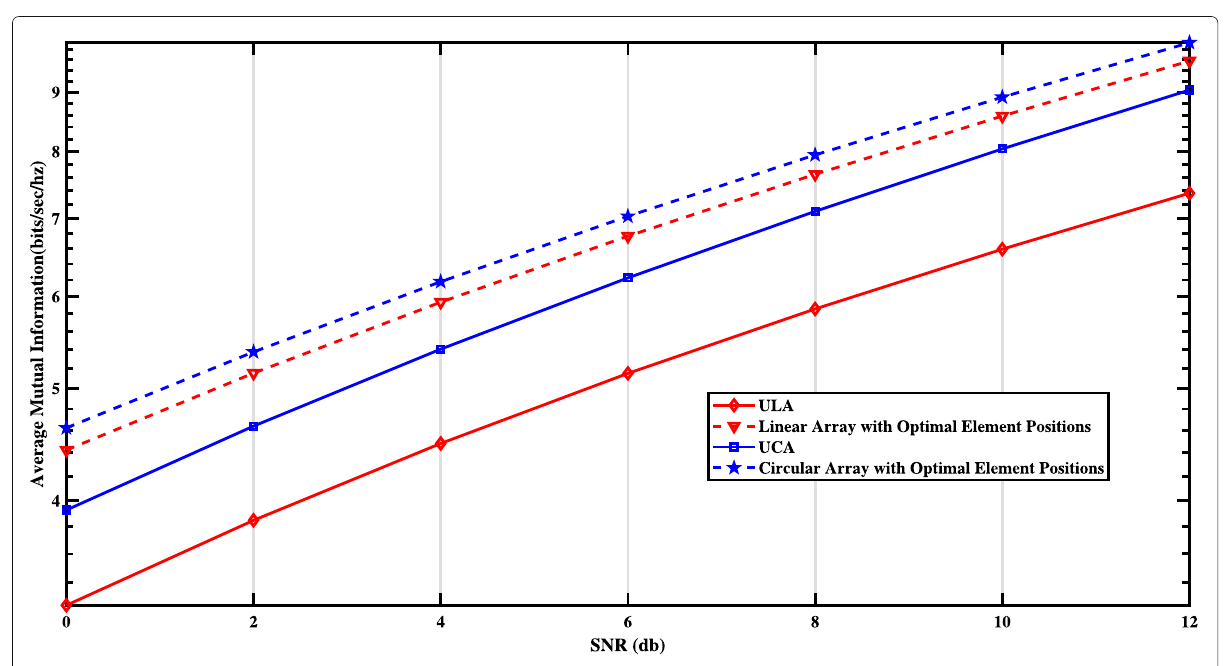
Fig. 4 The average mutual information for Example 1 with N B = 8 and N U = 2 Because the percentage of bandwidth and the half-power beamwidth for circular antenna array are wider than those for linear antenna array, circular antenna array provides higher gain than linear antenna array. (c) To mitigate MCE, circular antenna array is a more suitable geometri- cal arrangement than linear antenna array. The more array